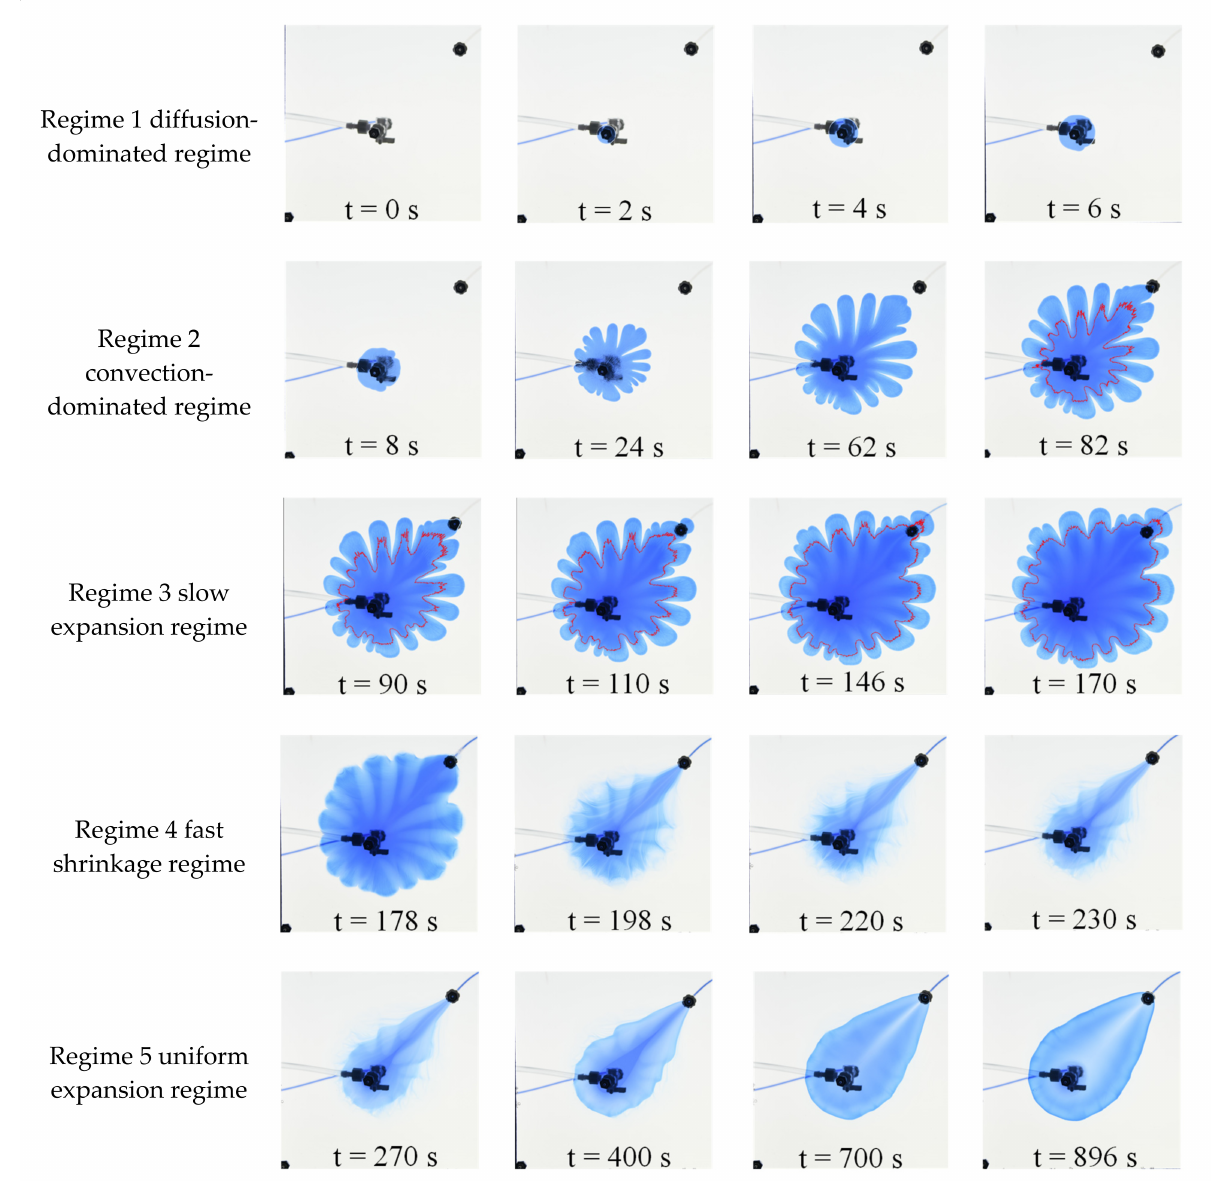
Figure 2. Different flow regimes at 5.0 mL/min at constant pressure control at the outlet. At t = 170 s, the maximum water plume is achieved. After that, a rapid shrinkage of injected water plume is observed until t = 230 s, which is referred to a fast shrinkage regime. Note that under the control of constant pressure at the outlet, the injection rate is constant, while the pressure at the injector and in the Hele–Shaw continues to increase before water is produced from the outlet. At t = 170 s, the pressure gradient from the injector to outlet is the highest, and the viscosity of fluids along the injector-to-outlet direction is the lowest. According to the Darcy’s law, the production rate will be very fast, resulting in a fast shrinkage of water plume. A clear fluid flow path and backward fingers can be seen at times from t = 198 s to t = 230 s in Figure 2. In this regime, an irregular pattern of water–glycerol interface is achieved with observed residual water distributed outside of the main water